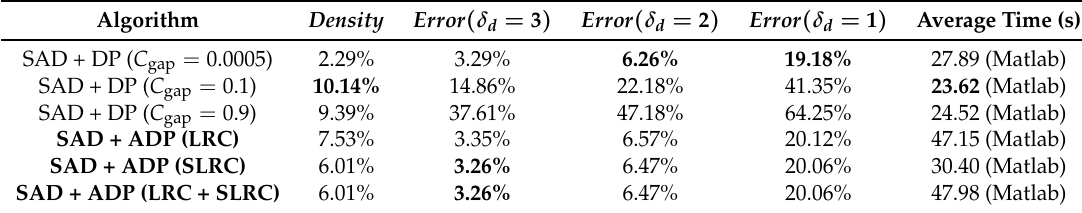
Figure 7. Examples of comparison between our method and the traditional dynamic programming algorithm. From top to bottom: the left images, the semantic edges, the disparity maps of the following algorithms separately: DP( C gap = 0.0005), DP( C gap = 0.1), DP( C gap = 0.9), ADP(LRC), ADP(SLRC). Table 1. Comparison between our method and the traditional dynamic programming algorithm.